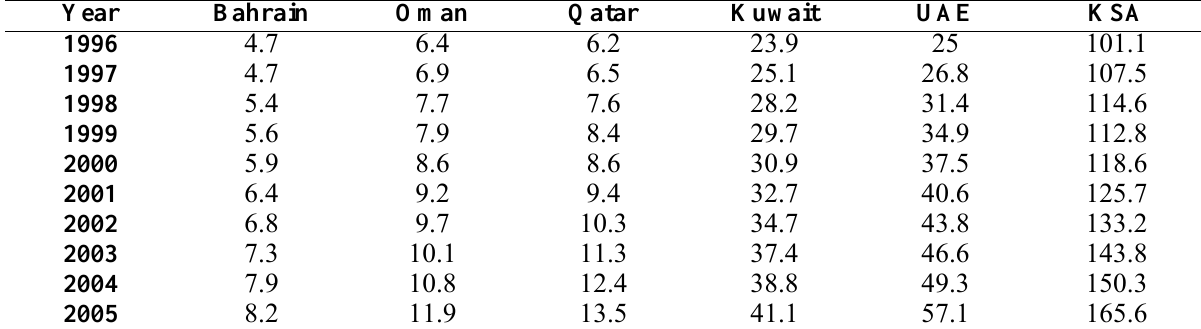
Table 2. Electricity generation in GCC (Billion